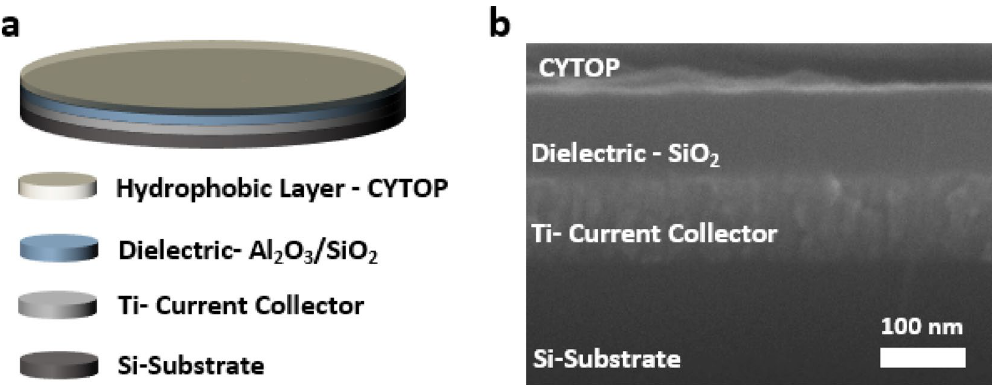
Figure 3. ( a ) Schematic of the metal and dielectric electrodes used for REWOD energy harvesting. ( b ) A cross- sectional view of a fabricated sample obtained by FE-SEM. The thickness of the titanium electrode was about 100 nm, and that of the Al 2 O 3 /SiO 2 dielectric layer was either 100 nm, 150 nm, or 200 nm (100 nm SiO 2 chosen for the SEM